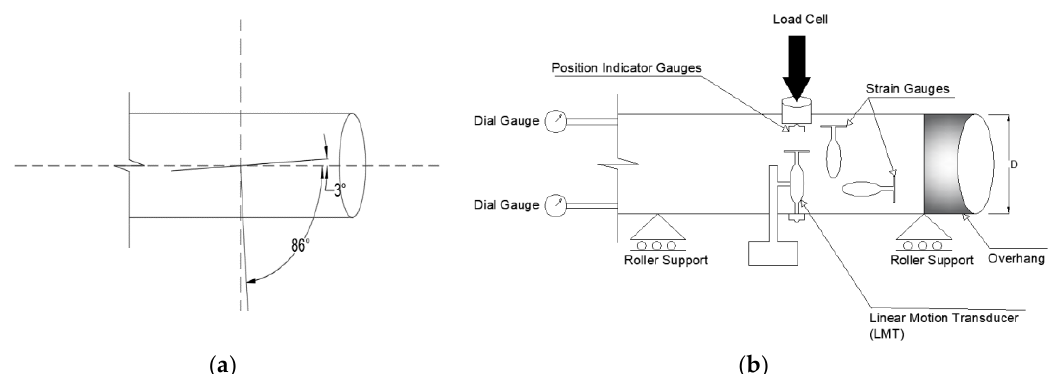
Figure 1. ( a ) Rotation of composite glass fiber-reinforced polymer (GFRP) fibers toward the longitudinal (35°) and hoop directions 3°, (left), ( b ) instrumentation of full-scale specimens using strain, dial and PI gauges along with Linear Motion Transducer (LMT) (right).